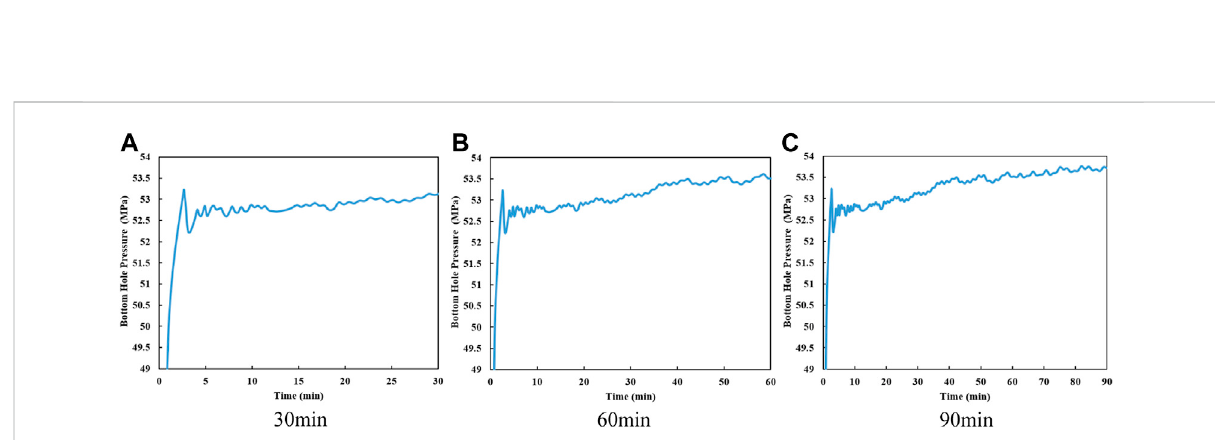
FIGURE 7 Curvesofbottomholepressureafter30min,60min,and90minofhydraulicfracturing.(wellboreresistanceisneglected,andthebottomhole pressure is the same in the fracturing